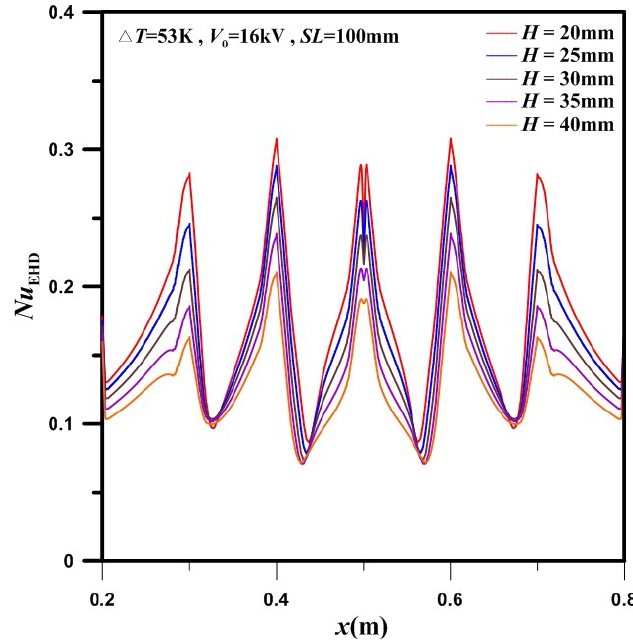
Figure 9. The variations in Nu EHD along the x direction for five electrode heights. (Δ T = 53 K, V 0 = 16 kV and SL = 100 mm).